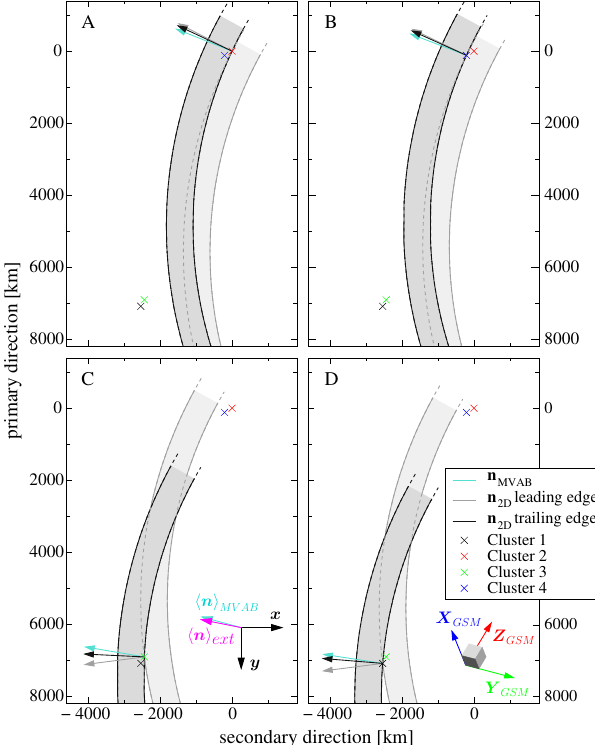
Fig. 9. The 2-D, non-planar MP motion in the plane perpendicular to the invariant direction, according to the C2 OpTA A solution. For a description of this picture see the